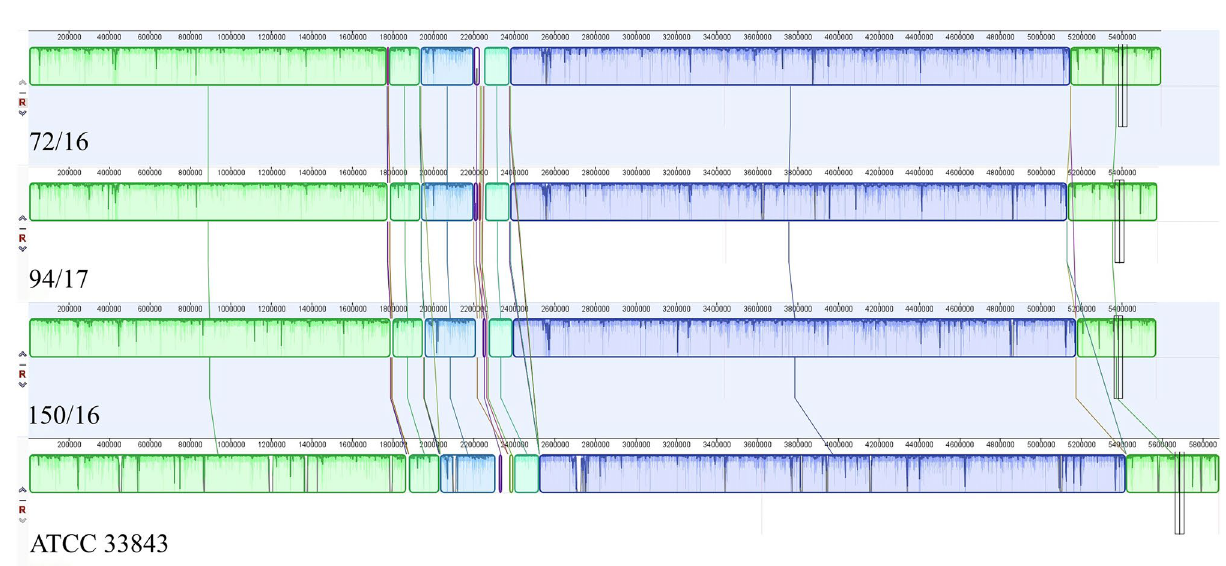
Figure 1. Progressive Mauve alignment of the consensus whole genome sequences of V . harveyi strains 72/16, 94/17, 150/16 and ATCC 33,843. The homologous regions are represented as collinear blocks with the same